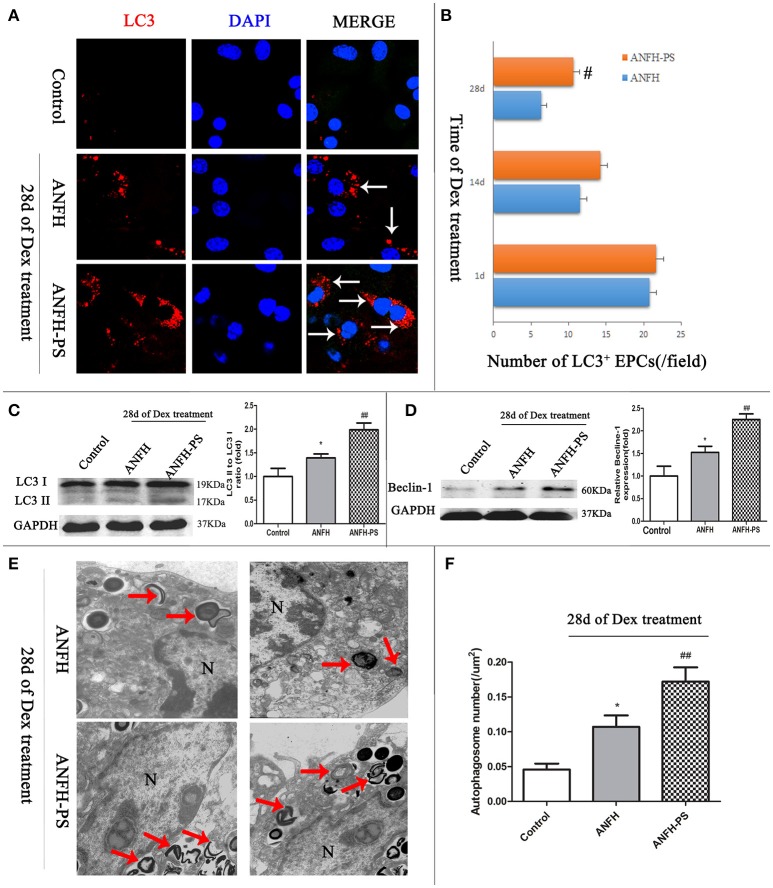
Pravastatin (PS) regulated autophagy of BM-EPCs in Dex-induced ANFH rats. (A,B) Immunochemistry and quantitative analysis showed that PS increased the number of LC3+ BM-EPCs in ANFH-PS rats. LC3+ BM-EPCs were stained in red, the white arrows indicated the LC3-punctate dots. Only the BM-EPCs containing more than 5 LC3-punctate dots were considered to be LC3+ BM-EPCs. (C,D) Immunoblotting assay showed that PS increased the LC3-II/LC3-I ratio and expression of Beclin-1 in BM-EPCs of ANFH-PS rats. (E,F) Representative electron micrographs demonstrated more autophagosomes formation in the ANFH-PS group than ANFH group. The red arrows indicated the double-membraned autophagosomes. N, nucleus. Scale bar, 1 mm. Values are expressed as the mean ± SEM of three independent experiments. n = 5 per group. *p < 0.05 vs. Control; #p < 0.05, ##p < 0.01 vs. ANFH.